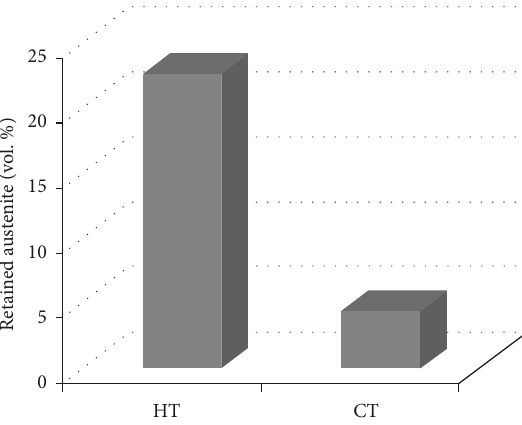
Figure 7: Retained austenite of AISI M2 tool steels.